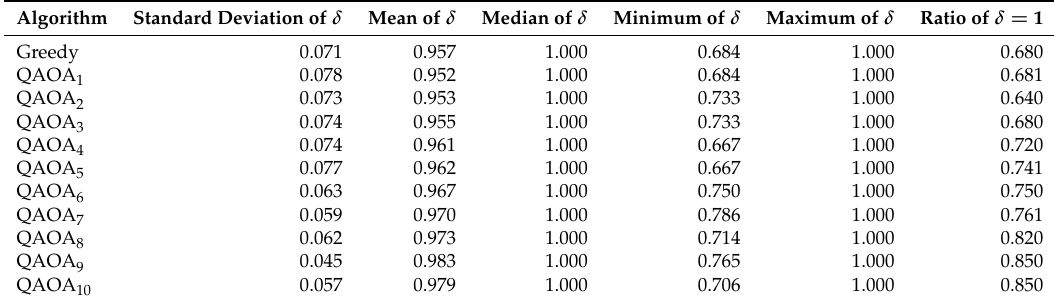
Table A1. Simulation data for the 3-regular weighted